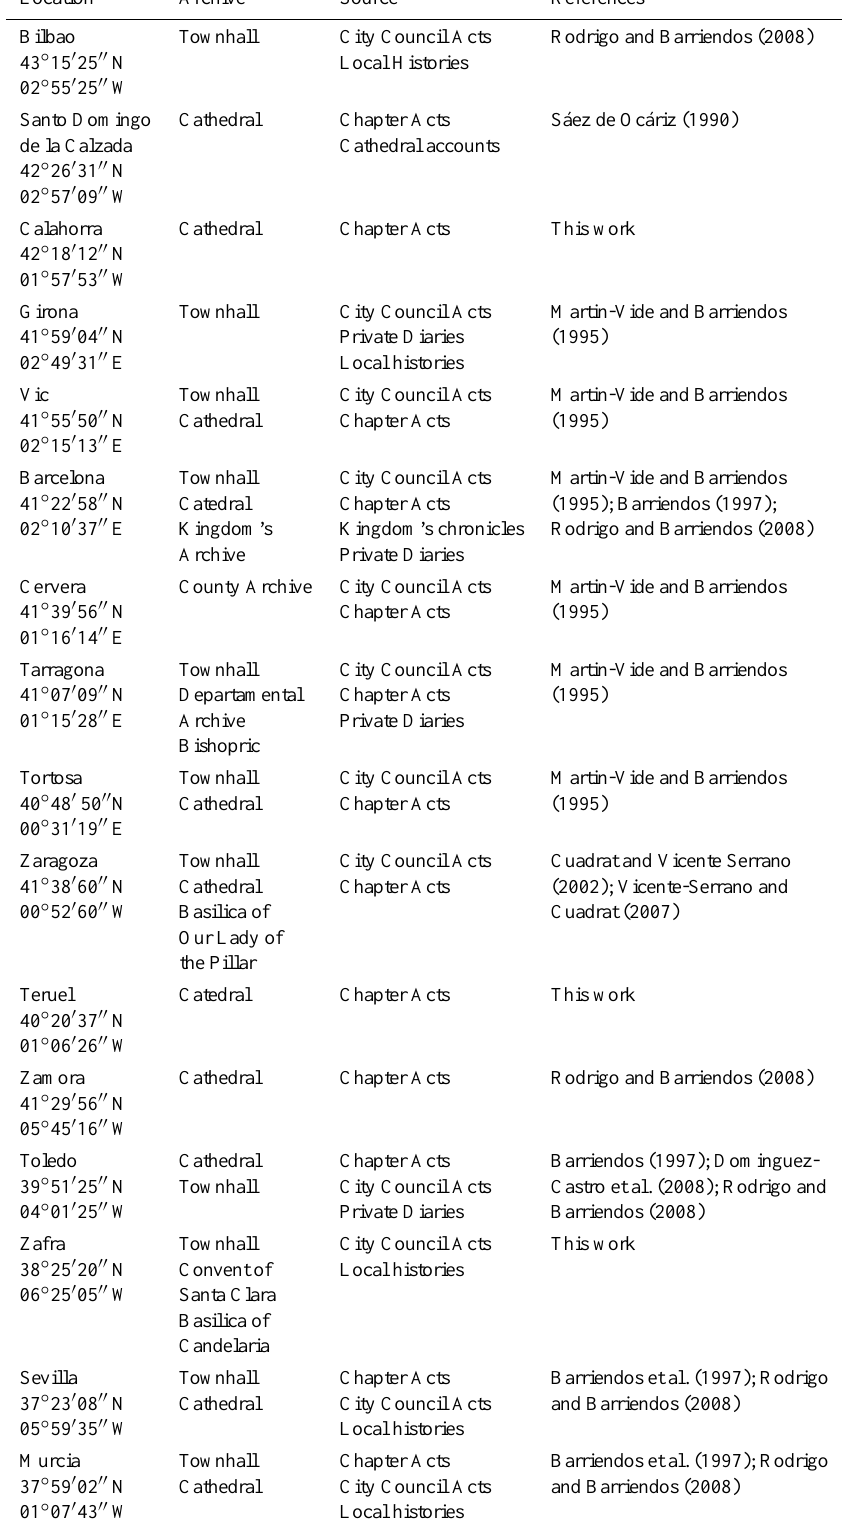
Table 1. Archives and sources consulted to generate the rogation series. For the details of the documentary sources consulted for Calahorra, Teruel and Zafra see Appendix